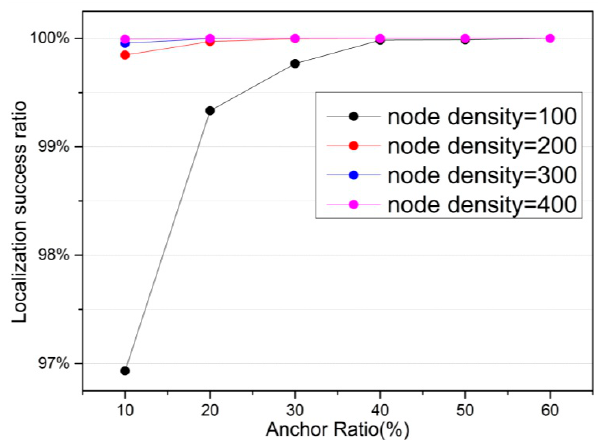
Figure 4. The effect of anchor ratio on localization success ratio.